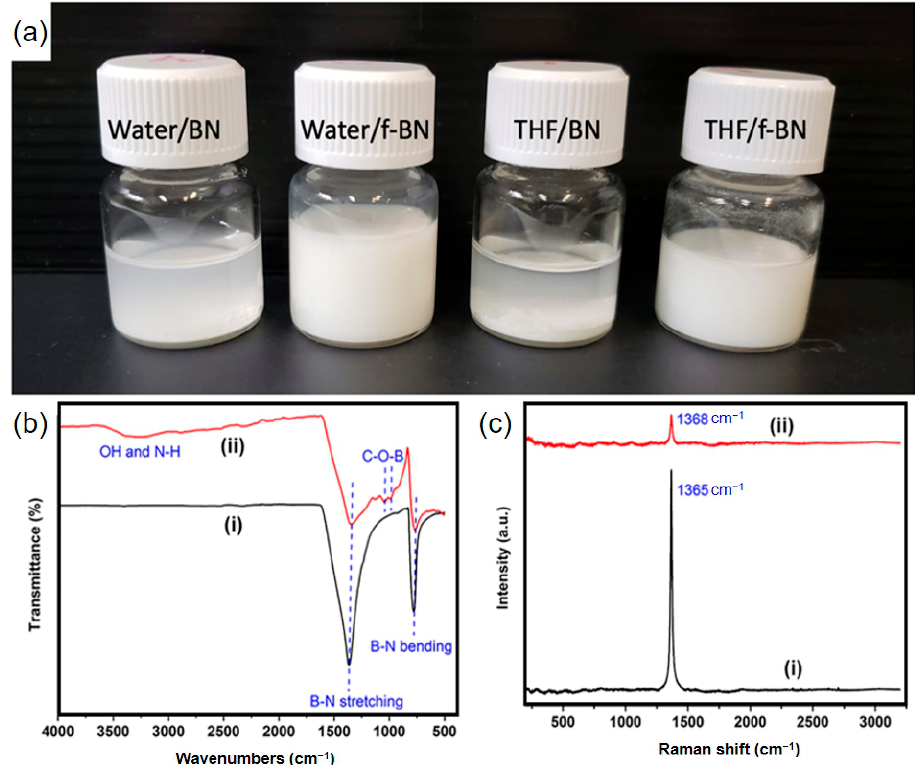
Figure 2. ( a ) Dispersion of h-BN and f-BN in water and THF. ( b ) ATR-FTIR and ( c ) Raman of the (i) h-BN and (ii) functionalized BN. h-BN and (ii) functionalized